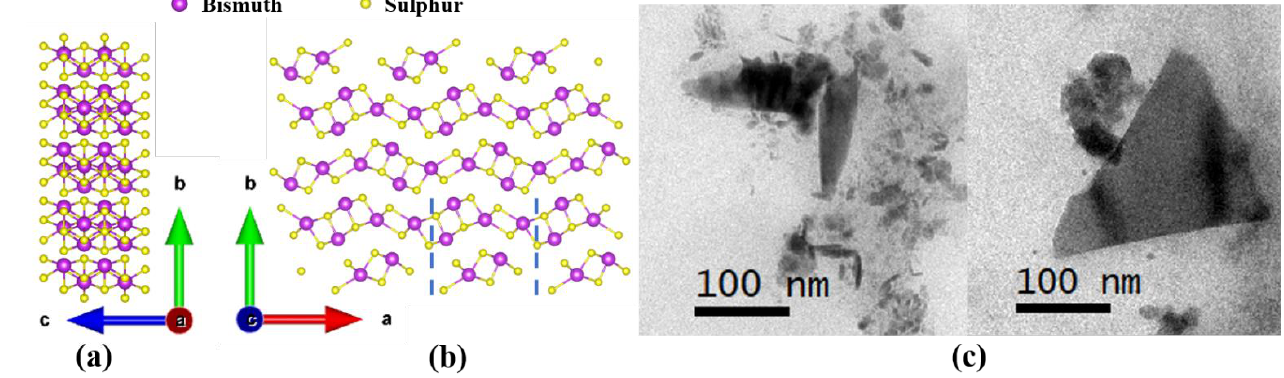
Figure 1. Crystal structure of Bi 2 S 3 : ( a ) top view from the a-axis and ( b ) top view from the c-axis. ( c ) TEM images of LPE Bi 2 S 3 /SC, demonstrating the presence of both Bi 2 S 3 NSs and monodimensional structures such as NRs.